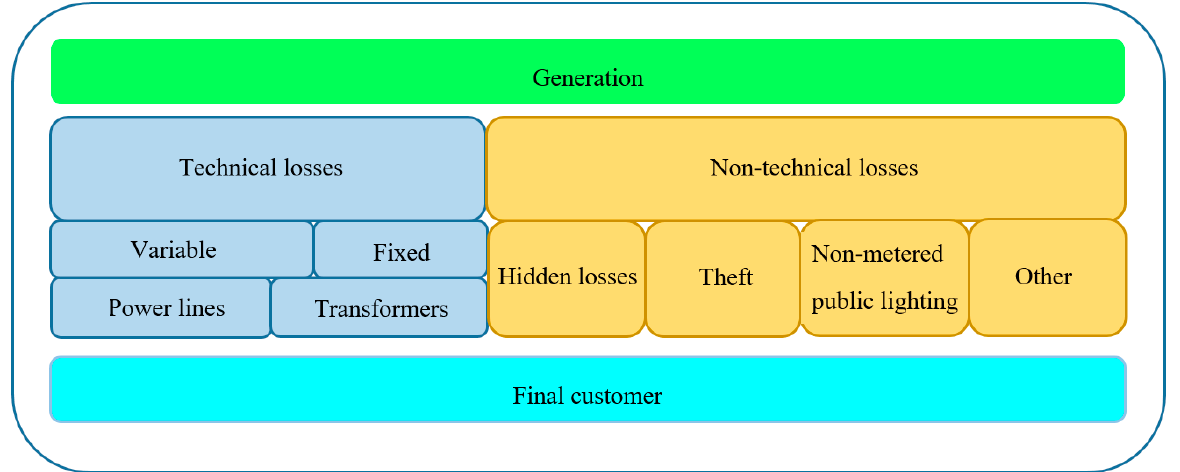
Figure 1. Typical categorization of power losses (adopted from [1], 2020, CEER).